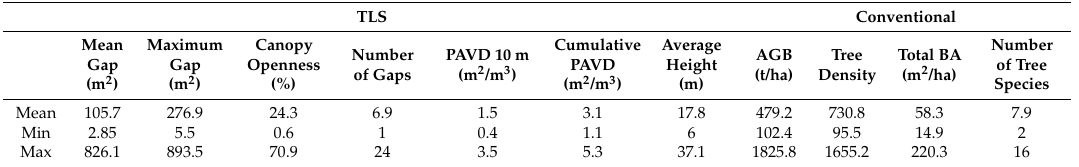
Table 1. Descriptive statistics of field-measured forest structural parameters from field plots ( n = 25). PAVD = plant area volume density, AGB = above ground biomass, BA = basal area.